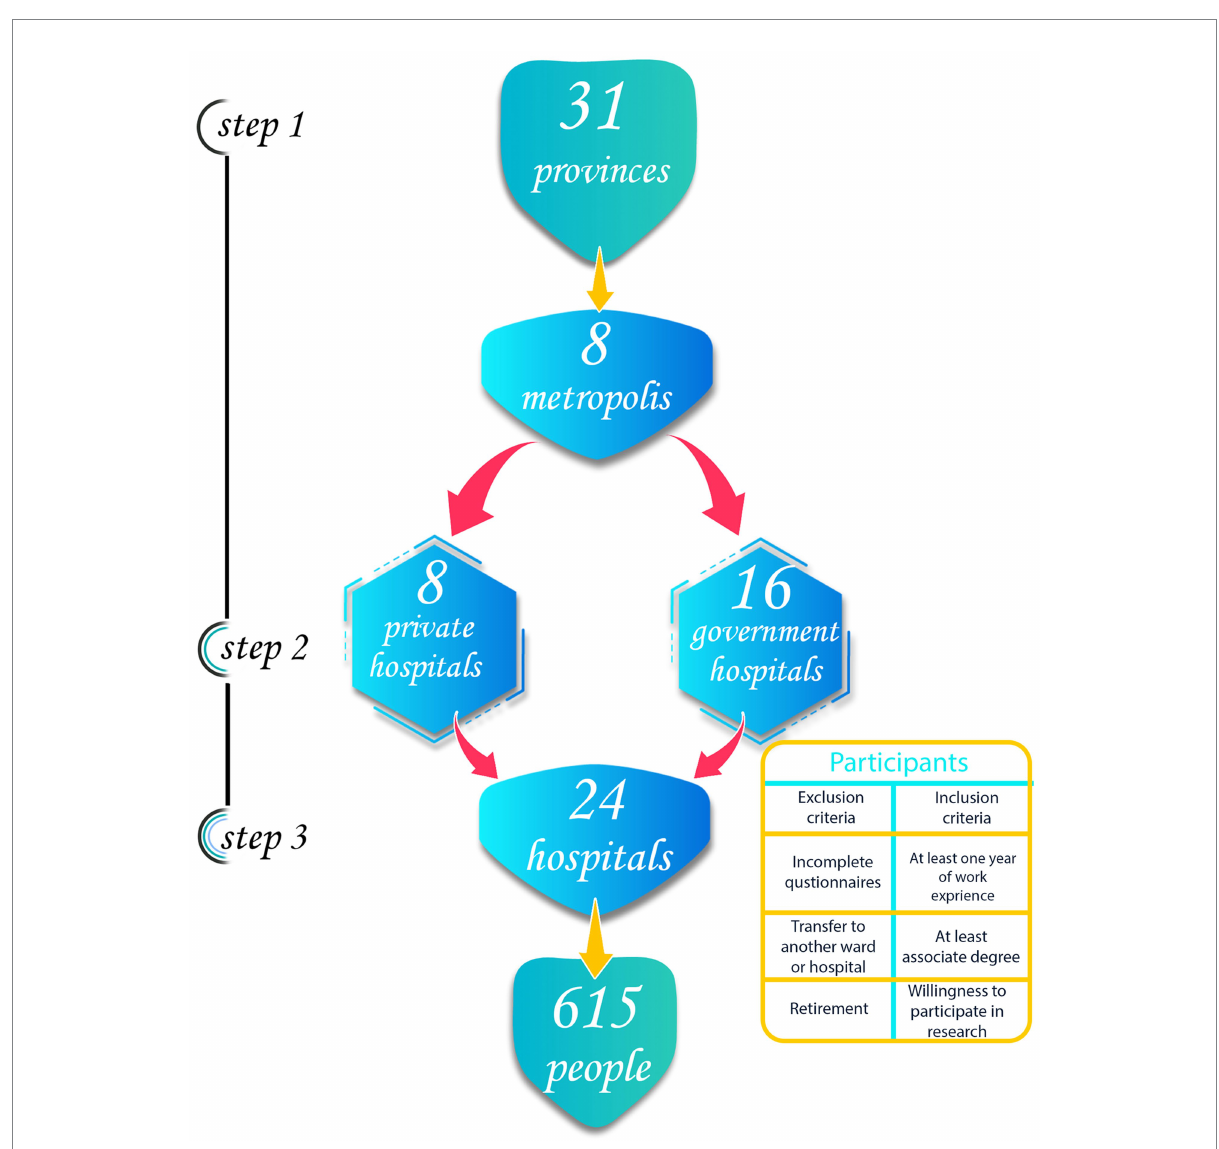
FIGURE 1 Multi-stage sampling